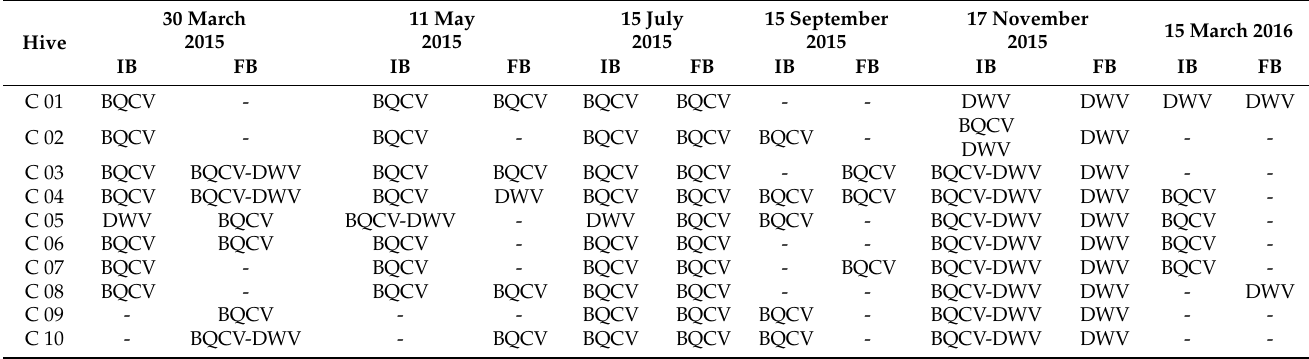
Table 3. Detections of Black queen cell virus (BQCV) and Deformed wing virus (DWV) during the study in non-forager (IB) and forager bees